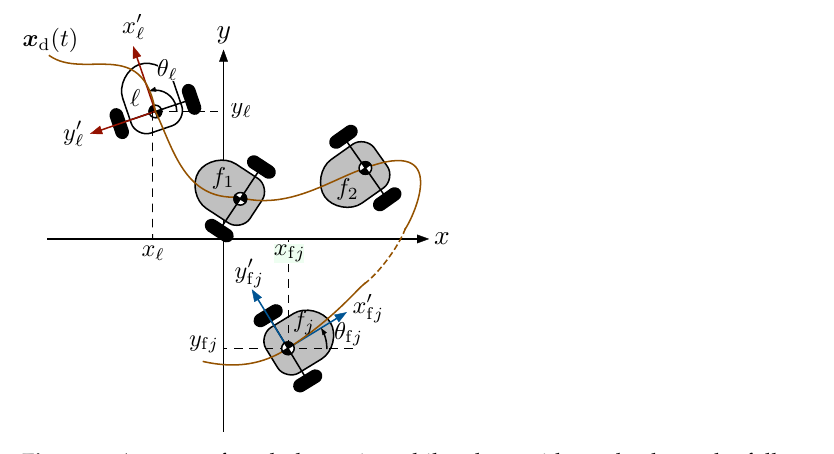
Figure 1. A group of nonholonomic mobile robots with one leader and n